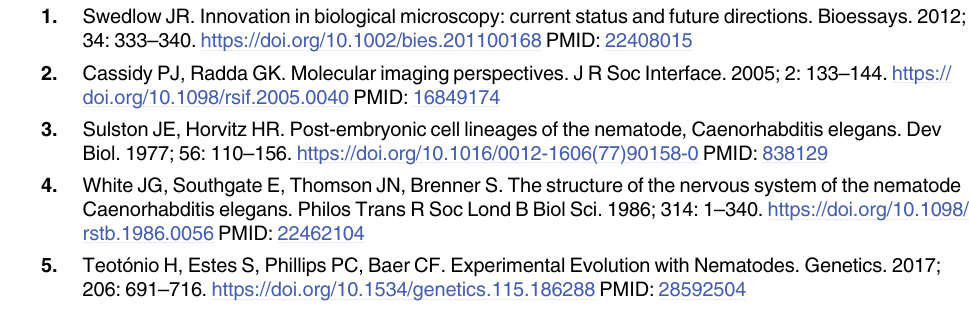
S3 Fig. Raw data from C . elegans growth experiment displayed by the function viewWell() . Similar to Fig 5, well images taken at (A) 9 hours indicating the L1 stage, (B) 28 hours indicat- ing the L2/L3 stage, (C) 46 hours indicating the L4 stage, and (D) 63 hours were analyzed. Here, the raw data results are displayed. The length of each identified object identified is shown in